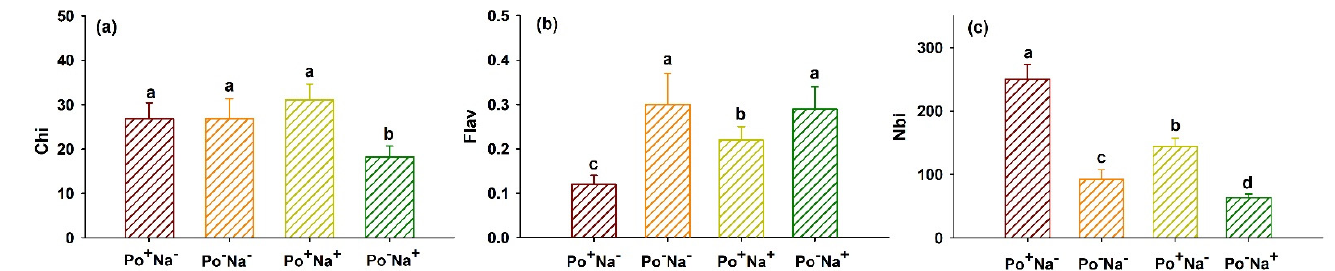
Figure 2. Changes in leaf chlorophyll index (Chi) ( a ), flavonoid index (Flav) ( b ), and nitrogen balance index (Nbi) ( c ) of tomato plants colonized by Paraglomus occultum under 0 and 150 mM NaCl stress. Data (means ± SD, n = 6) followed by different letters on the bar indicate significant differences among treatments at the 0.05 level. See Table 1 for abbreviations.